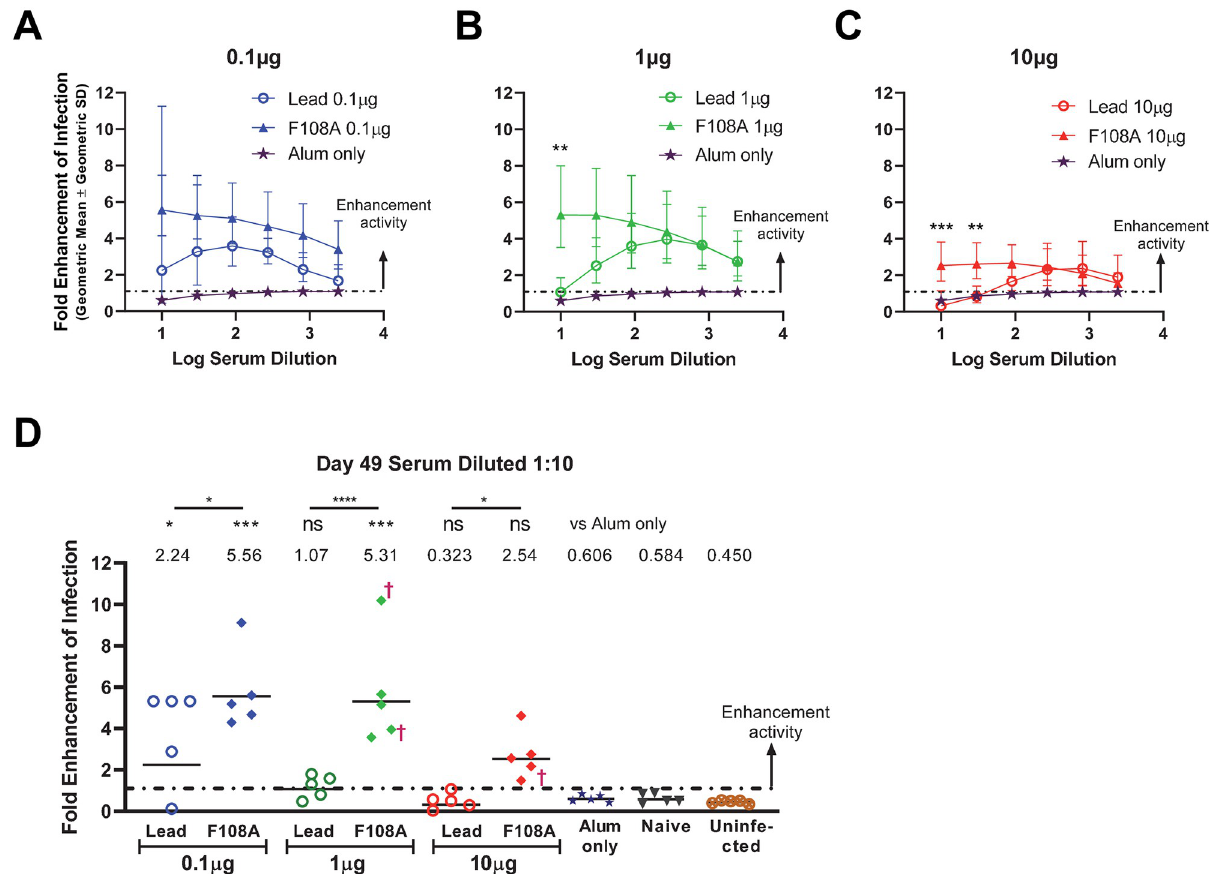
Fig 7. Ab-dependent Enhancement in vitro assay. (A-C) Fold enhancement of infection is represented for each serum dilution tested, ranging from 10-fold up to 2,430-fold. Fold-enhancement reflects the ratio of the percentage of cells infected with diluted serum-treated virus to medium only-treated virus. The calculated cutoff for ADE activity, shown by dot and dashed line, was calculated as the mean fold-enhancement values of the negative control groups (Alum-only, na ï ve, and uninfected) + 3 standard deviations (SD). Each symbol indicates the geometric mean of a dose group (5 mice), and error bars represent geometric SD. The three dose groups, 0.1 μ g (A), 1 μ g (B) and 10 μ g (C), were separated into different graphs in which lead and F108A VLP-immunized mice are compared. The Alum-only group is shown in each panel for comparative purposes. Statistical comparisons of enhancement data were performed at each dose using one-way ANOVA test followed by pairwise Sidak’s multiple comparisons between lead and F0108A groups at each serum dilution ( � P < 0.05; �� P < 0.01; ��� P < 0.001; ���� P < 0.0001; ns, not significant). (D) Fold-enhancement of infection of cells infected with the 10-fold serum dilution. Each symbol represents the geometric mean of two independent measurements for an individual animal. Horizontal bars represent the geometric mean titer of each group. The symbol † denotes a mouse that succumbed after challenge. Statistical comparisons were performed using ANOVA test followed by Dunnett’s multiple comparisons tests with significance levels denoted as in (A-C) above. All VLP groups were compared to the Alum-only group. Additional pairwise comparisons were performed between titers of lead and F108A groups at each dose with significance level for each comparison shown above each